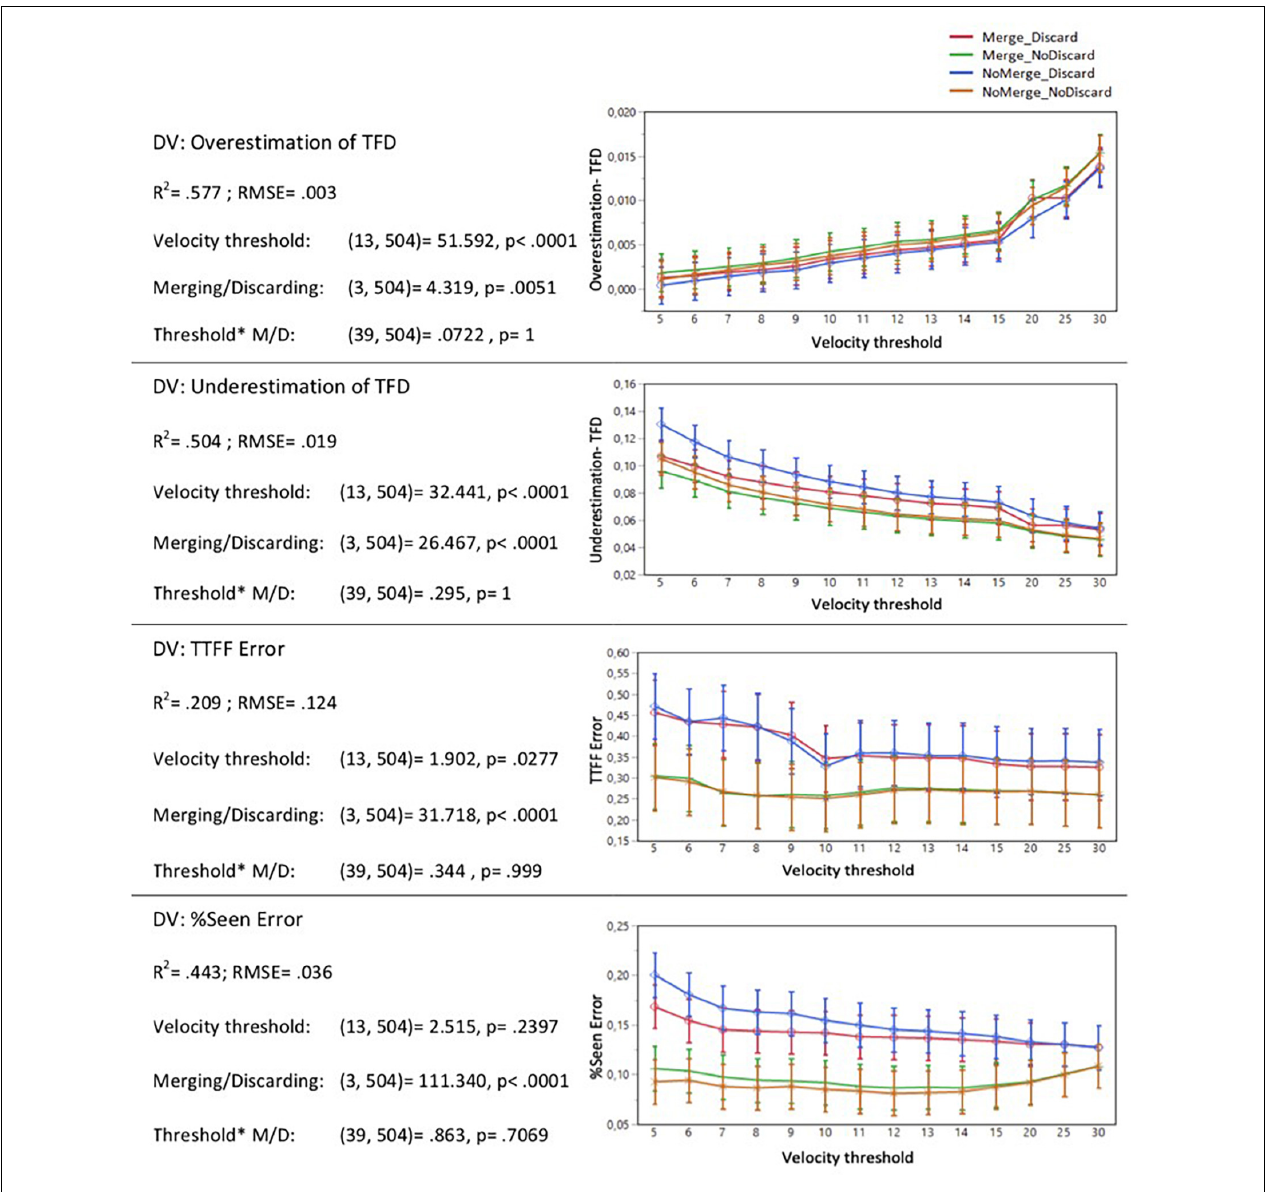
FIGURE 4 | Error components of different eye-tracking metrics as a function of different fixation detection algorithm parameters for AOI “Branding”.